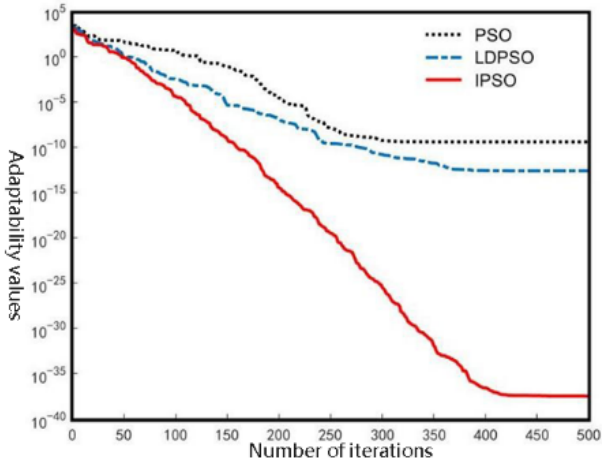
Figure 1. Convergence of Sphere function.